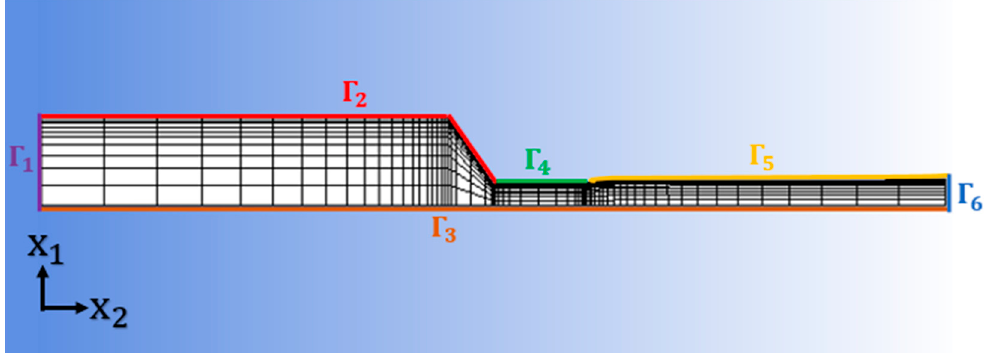
Figure 5. Mesh and boundary condition of the flow domain.